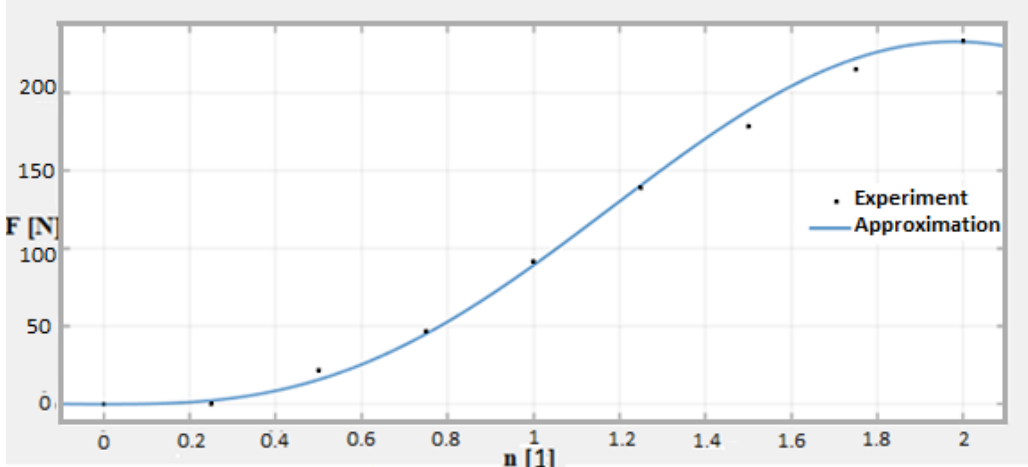
Figure 16. Approximation curve for the 2nd measurement for acquired m = 1.417 (R 2 = 0.9969).